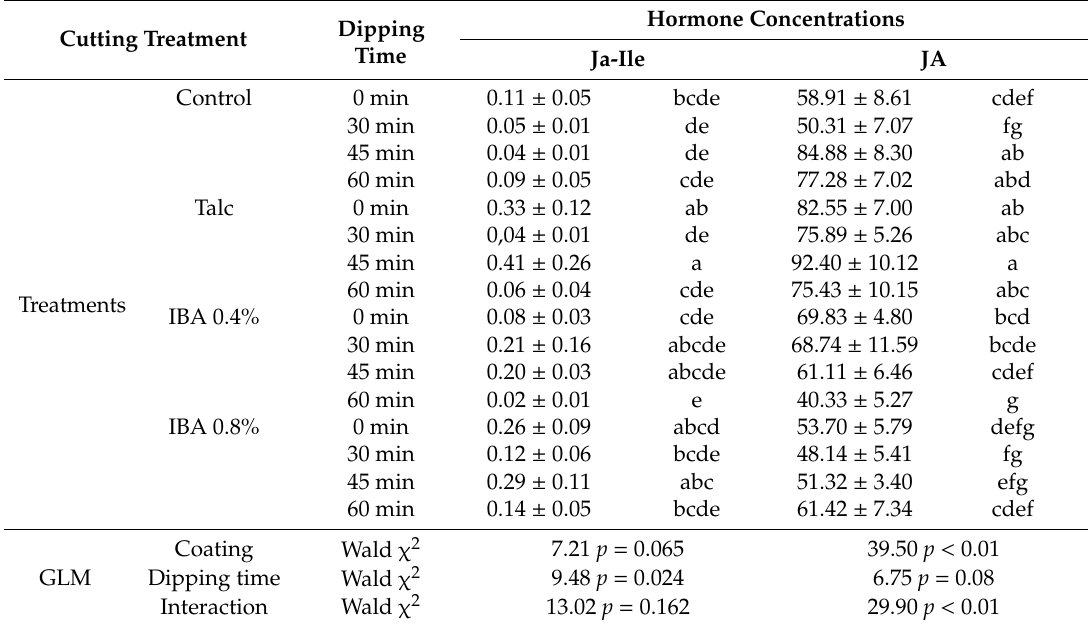
Table 1. Hormonal profiling upon cutting treatments. Hormone concentrations are expressed as a mean in ng / mg freeze dried leaf material ± SEM ( n =